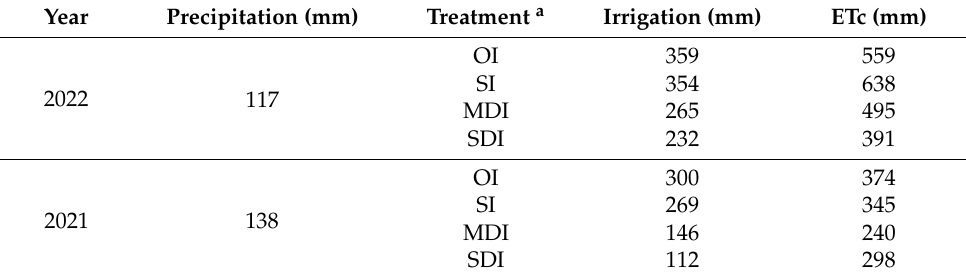
Table 4. Seasonal precipitation, irrigation, and alfalfa crop ET